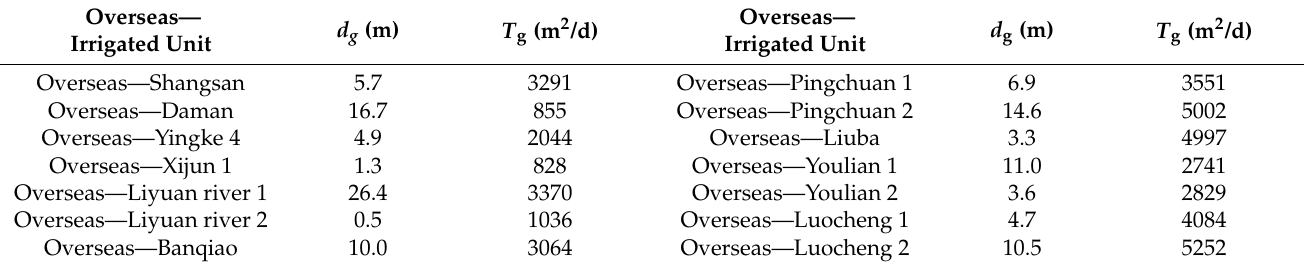
Table 3. Optimal values of slope width product and water conductance of submersible flow from outside to an irrigated area.